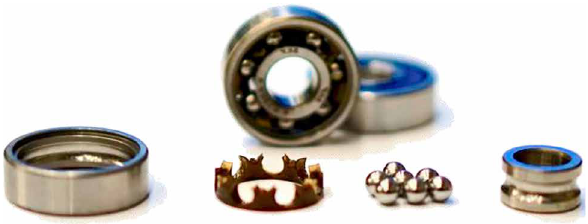
Figure 3: Bearing 608 disassembled into its components. From left to right, outer raceway, cage, balls and inner raceway. Assembled bearings are shown in the